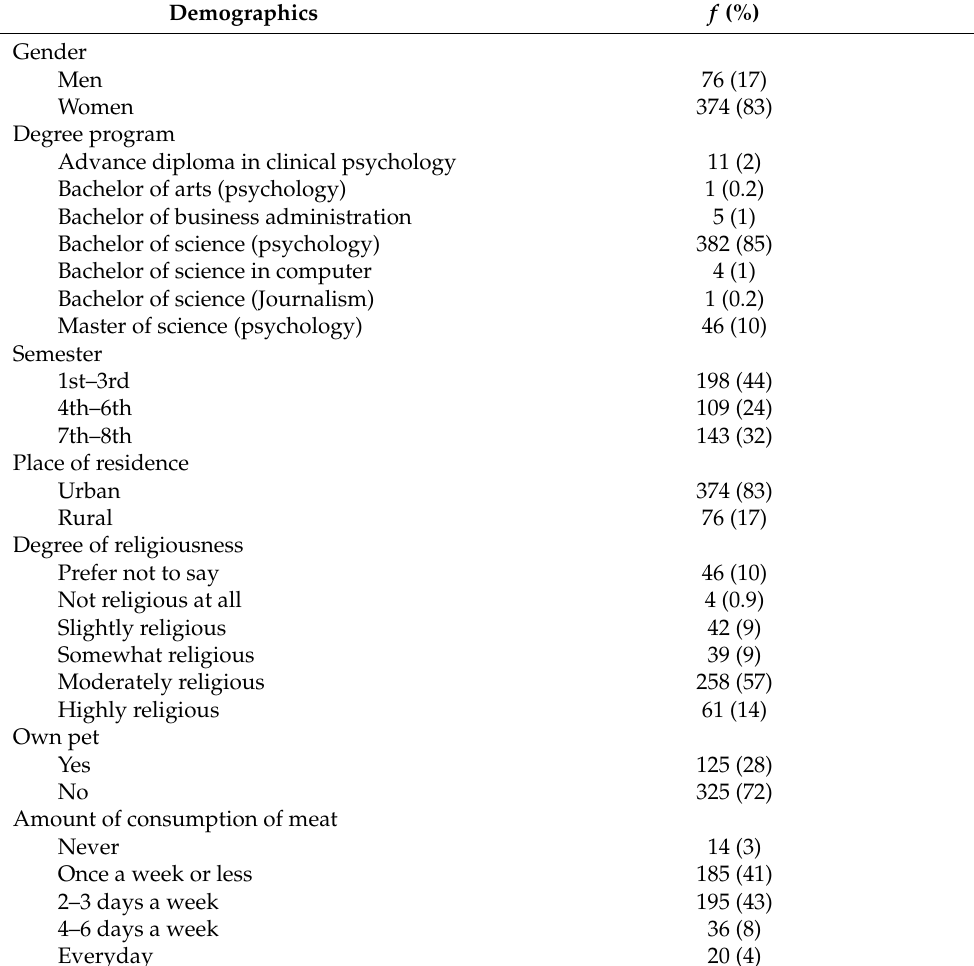
Table 1. Frequencies and Percentages along Demographic Variables (N =